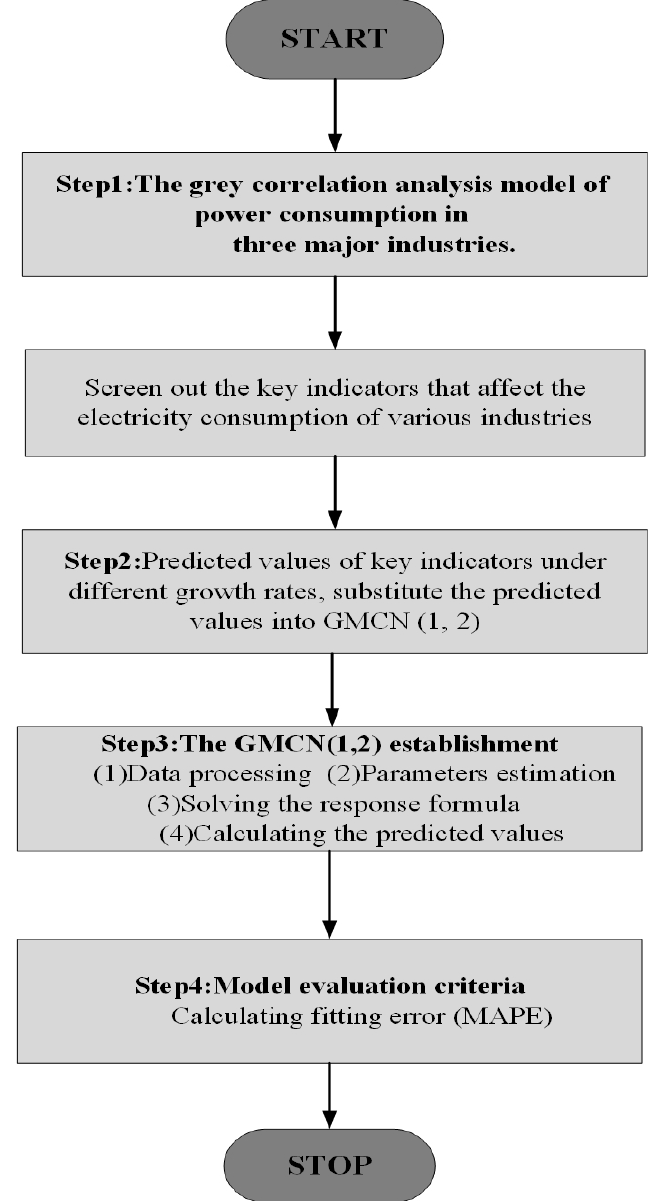
Figure 1. The process of three major industrial power forecasting.